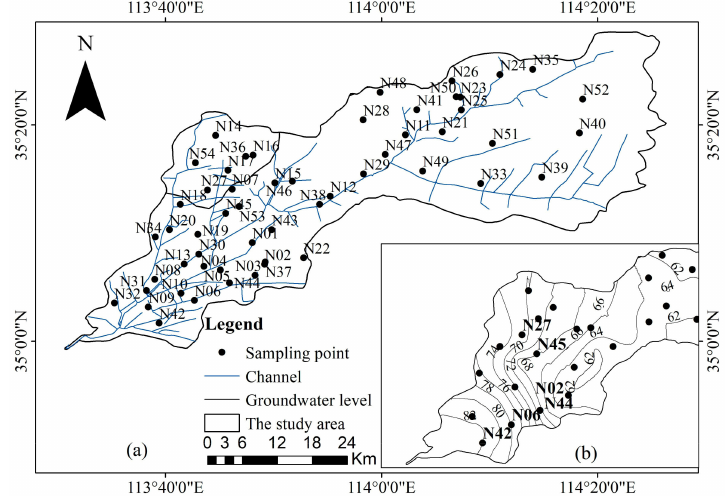
Figure 2. Location map showing sampling site of the study area. (( a ) is the distribution of all sampling points, ( b ) is sampling points of runoff path selected for inverse geochemical modeling in